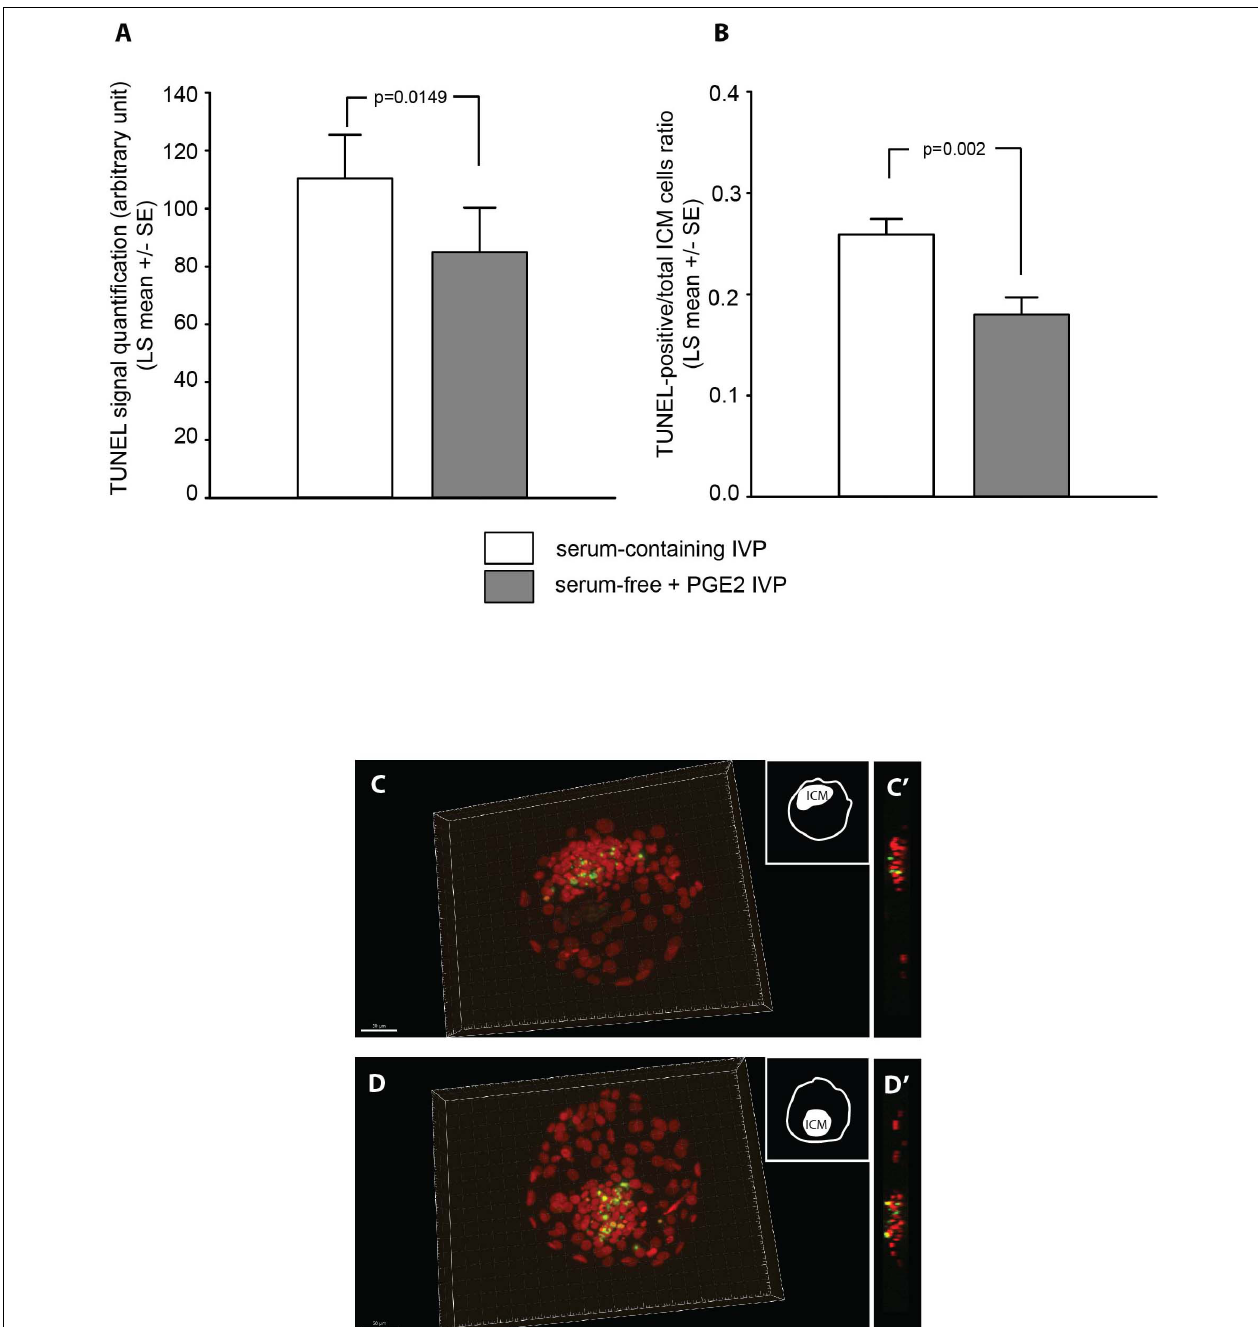
FIGURE 6 | Quantification of TUNEL signals detected in the inner cell mass (ICM) of grade-I 7 dpf bovine blastocysts derived from “serum-containing” and “serum-free + PGE2” in vitro production (IVP) (A,B) . Samples sizes were n = 29 and 24, respectively. Values are represented as LS mean ± SE. Photomicrographs show representative 3D images of low (C) and high (D) levels of TUNEL signals (green) observed in blastocysts. Photomicrographs (C’,D’) represent an orthogonal view of the ICM. The chromatin is counterstained with DAPI (presented in red to contrast with the